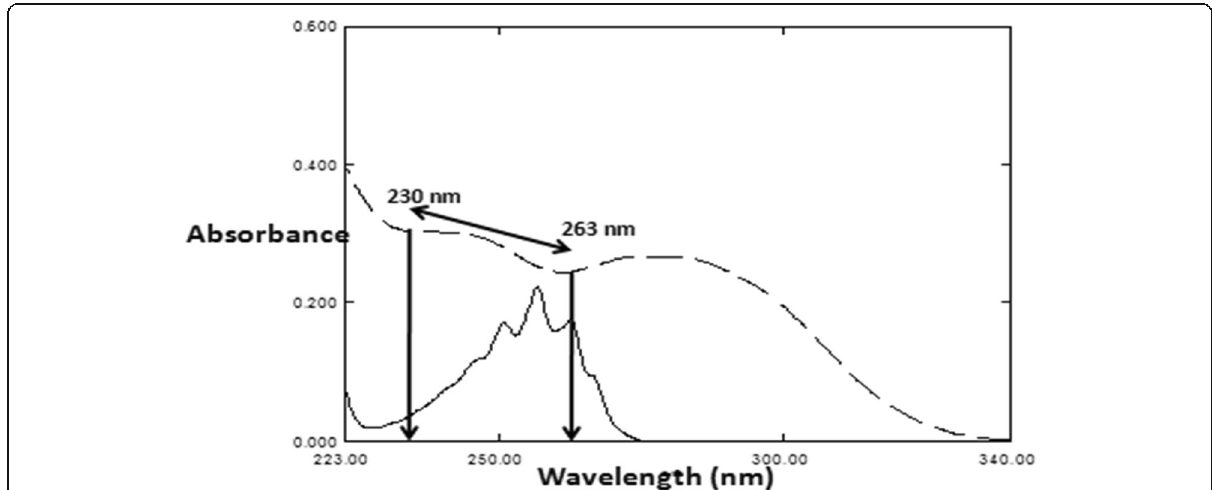
Fig. 4 Zero-order absorption spectra of PSE (s/b f) 240.0 μ g/mL and LOR (s/b g) 10.0 μ g/mL showing absorbance difference at 230 nm and 263